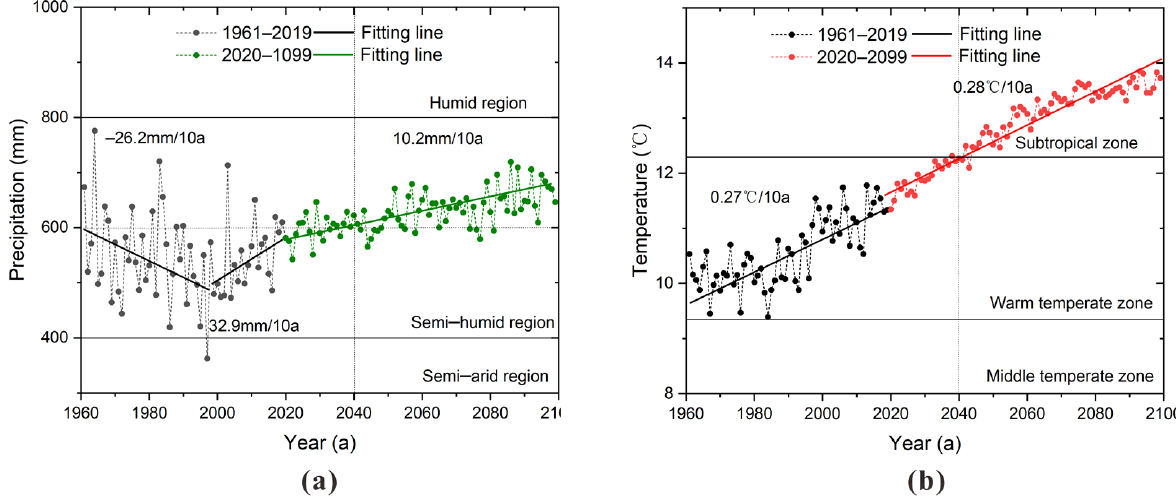
Figure 9. Observed and predicted temperature( a ) and precipitation( b ) values.